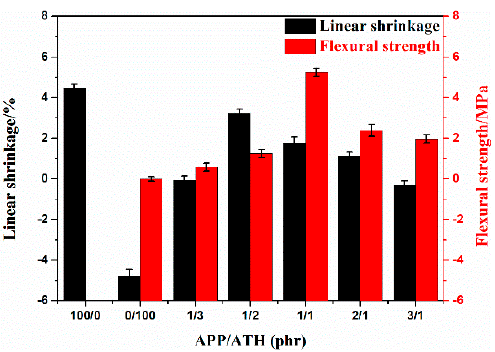
Figure 2. The flexural strength and linear shrinkage of the sintered specimens.